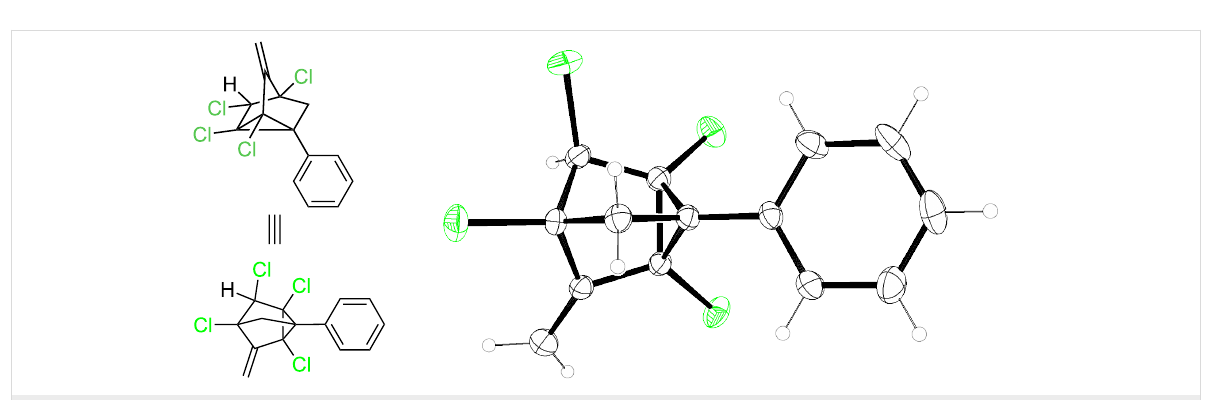
Figure 1: X-ray crystal structure of 5a with 30% thermal ellipsoids.